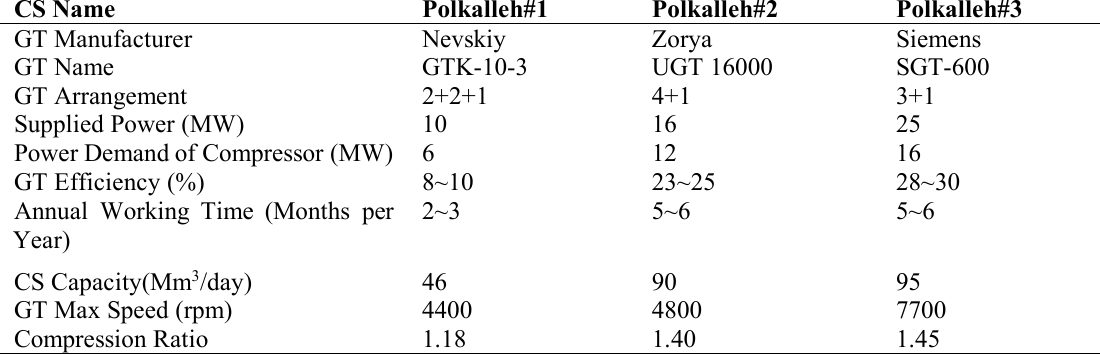
Table 3. Detailed information and specification of Polkalleh compressor station